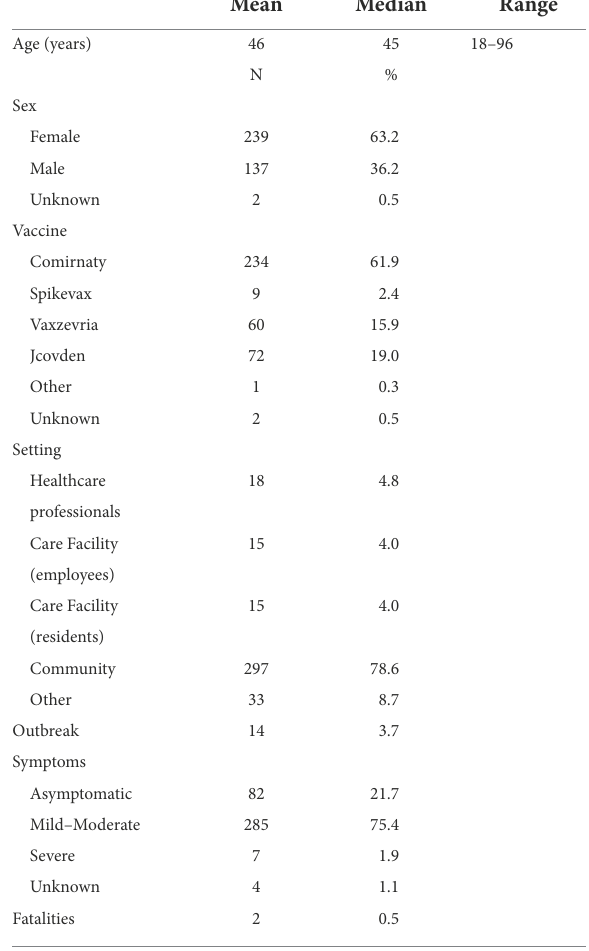
TABLE 1 Characteristics of the study